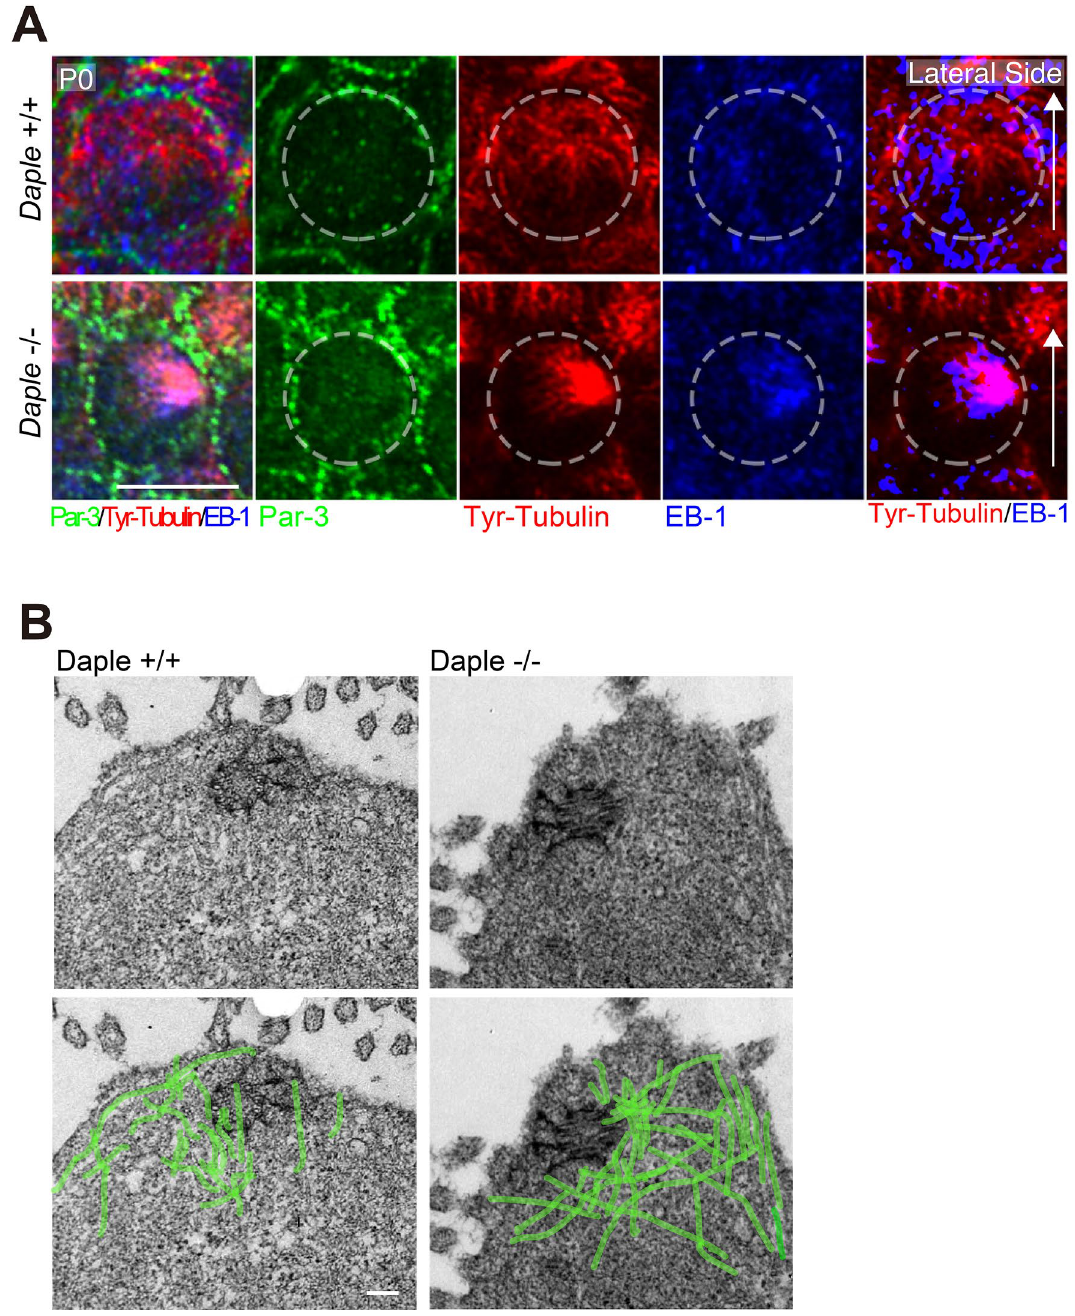
Figure 5. EB-1/Tyr-tubulin staining and transmission electron microscopy (TEM) images. ( A ) These images were generated from Fig. 4C to show the clear distribution difference of microtubules and EB-1 between Daple + / + and Daple −/− mice. The dotted line circle shows the cell border. The rightmost figures, where the EB-1 distribution was binarized using Photoshop software and merged with the staining of Tyr-Tubulin, showing characteristics distribution of Tyr-Tubulin and EB-1. The distribution of EB-1, a microtubule plus-end binding protein, was observed near the lateral membrane of hair cells (HCs) in Daple +/+ mice. However, EB-1 in Daple −/− HCs was more densely aggregated in the cytoplasm. Scale bar: 5 μm. ( B ) The microtubular network extending from the basal body was clearly observed in murine Daple +/+ HCs. However, the microtubules exhibited a denser distribution around basal bodies in Daple −/− mice. Microtubules were identified by their properties, for example, around 25 nm diameter, tube-like high density structure 23 . Scale bar: 1